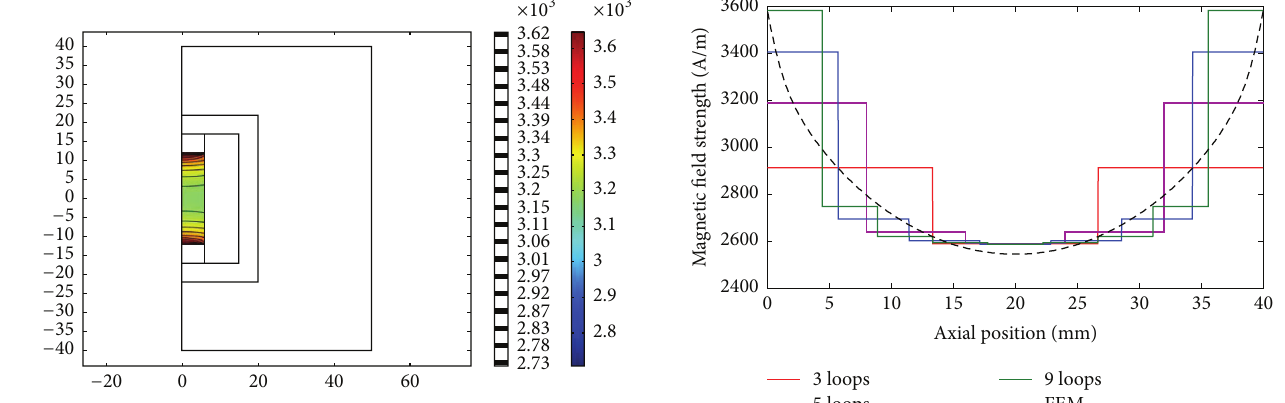
Figure 4: Contour plot of magnetic field distribution in single GMM case.